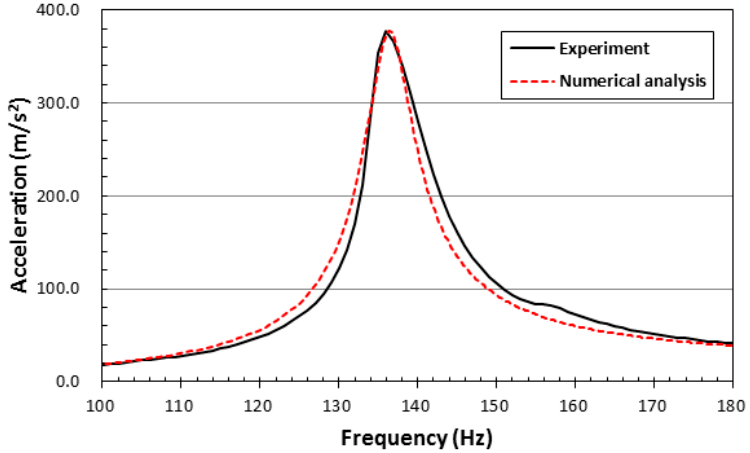
Figure 14. Graph of a comparison between vibration analysis and experimental results.